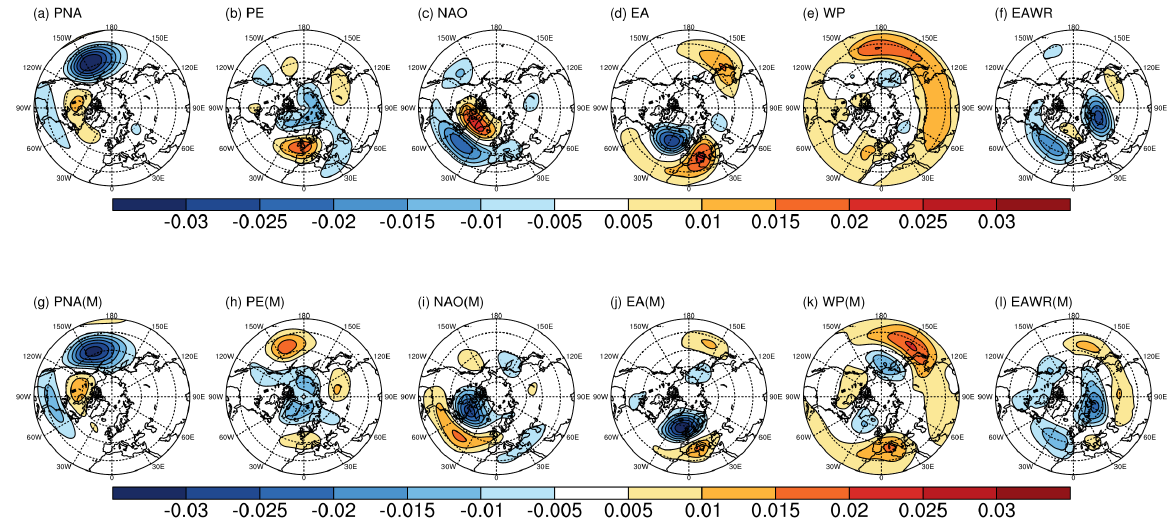
Figure 2. Teleconnection patterns of northern hemispheric (20–90° N) 500 hPa geopotential height (Z500) anomalies using ERA5 reanalysis products for ( a ) PNA (Pacific/North American), ( b ) PE (Polar/Eurasia), ( c ) NAO (North Atlantic Oscillation), ( d ) EA (East Atlantic), ( e ) WP (West Pacific), and ( f ) EAWR (East Atlantic/Western Russia) ( Top ). ( g – l ) are the teleconnection patterns of the GloSea5 (M) model ( Bottom ). The (M) denotes the GloSea5 model. Table 2. Pattern correlation coefficient (PCC) of six teleconnection patterns between the GloSea5 model and ERA5 reanalysis data. PNA PE NAO EA WP EAWR Pattern Corr. 0.92